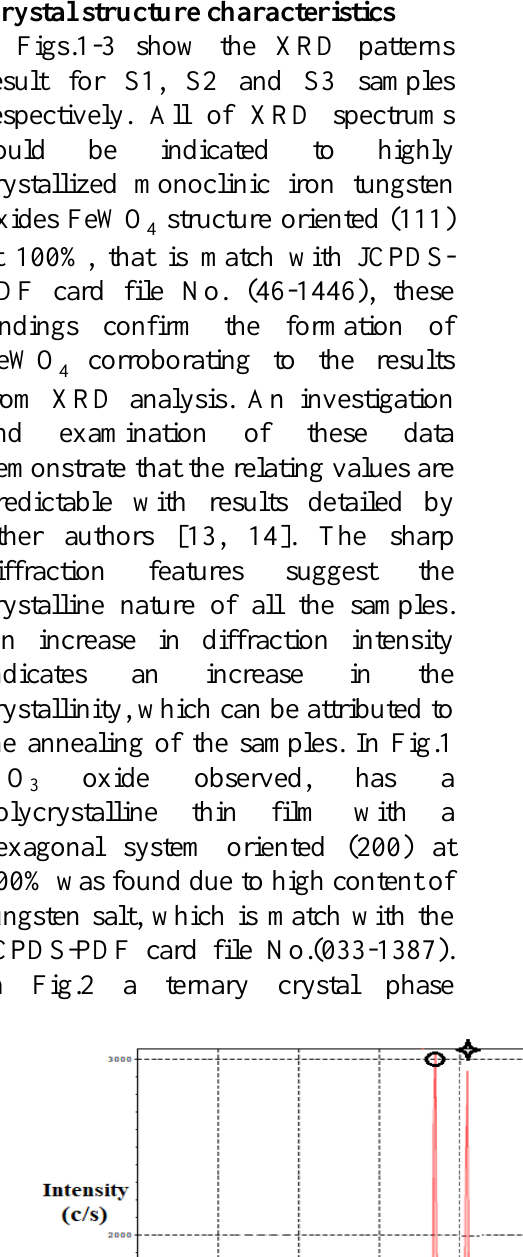
Fig. 1: XRD spectra of S1 sample.